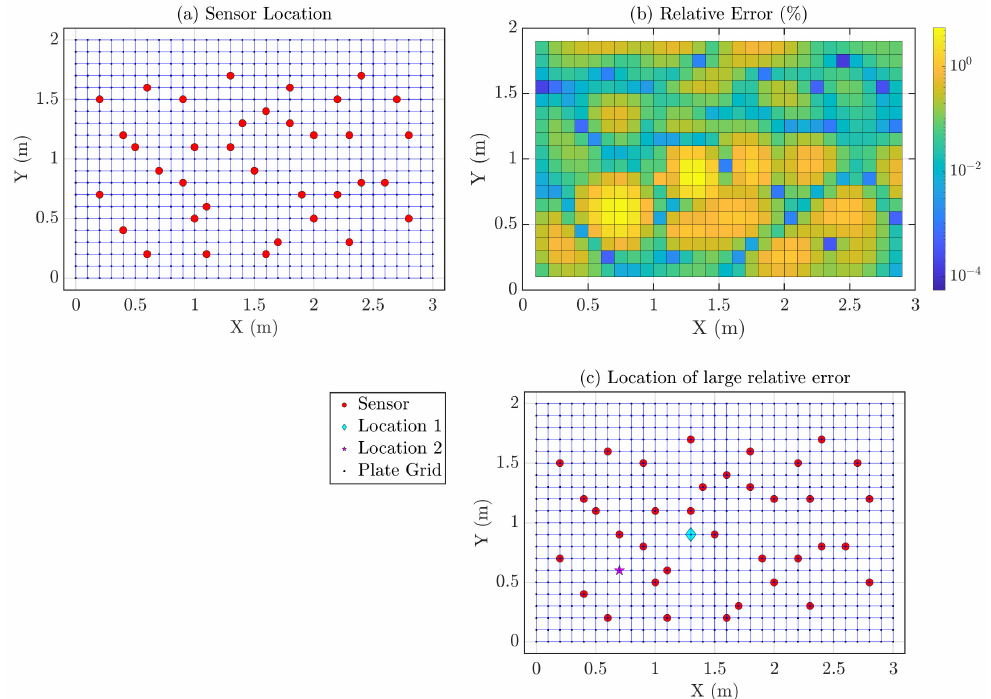
Figure 9. ( a ) Location of 36 stratified randomly placed sensors (shown as ‘red circles’) on the simply supported rectangular plate; the objective is to estimate the responses of all the grid points (‘blue intersections’); ( b ) Relative Errors ( (cid:101) i ) in % for the virtual dense sensing points; ( c ) Locations of interest with comparatively large relative errors (%). Such locations are denoted as ‘cyan diamond’ and ‘magenta